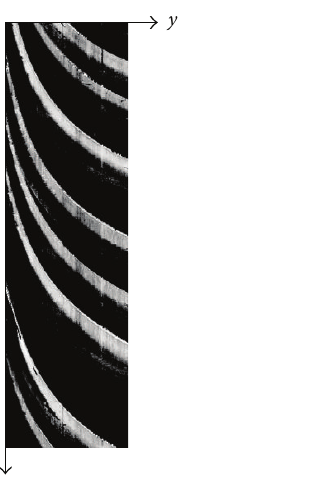
Figure 13: A spatiotemporal image (ST-IMG) in lane 2.